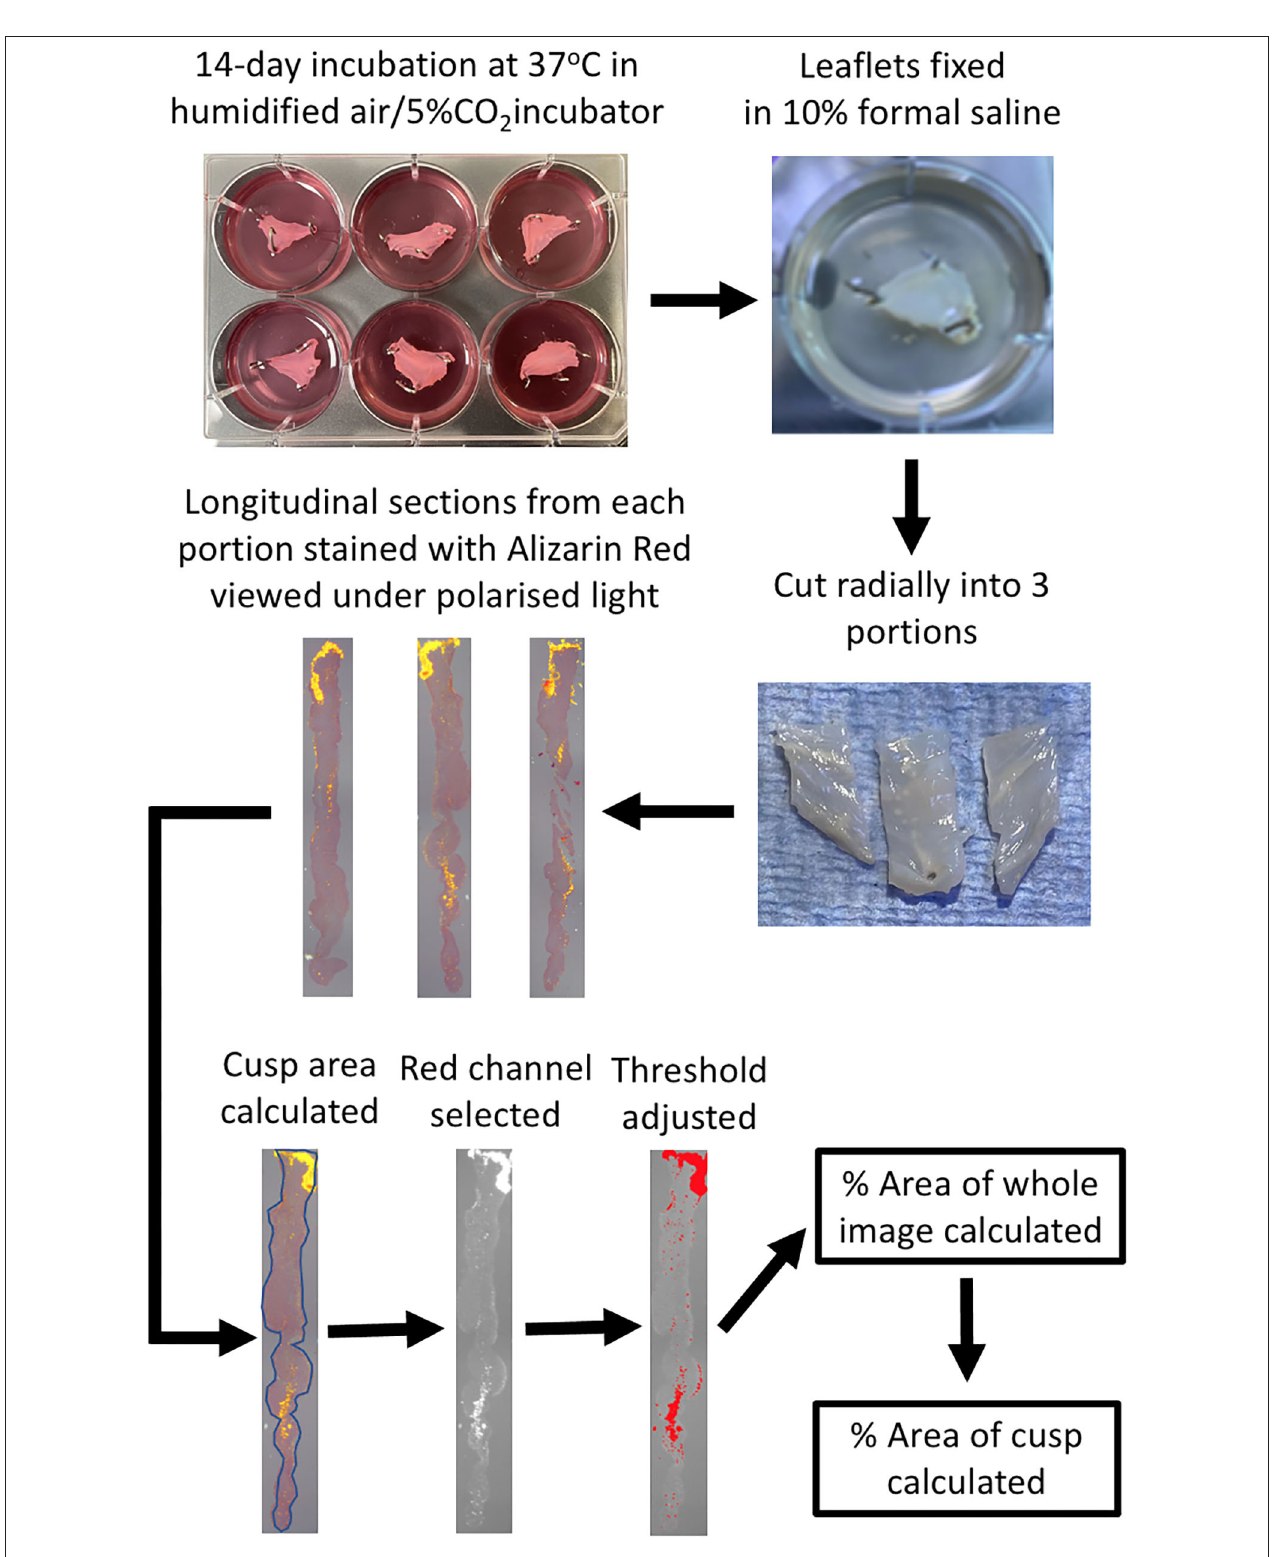
FIGURE 1 | Schematic diagram of the experimental protocol. Following incubation of the pinned-out valve leaflets, they are fixed while still in the wells with 10% formal saline. Each leaflet is cut into 3 portions radially, processed and embedded in wax blocks and cut longitudinal sections cut on a microtome. Alizarin Red staining of a slide from each of the three leaflet portions is viewed under polarized light and then quantified using Image J, to ultimately calculate the percentage of the area of the leaflet that stains for Alizarin Red.